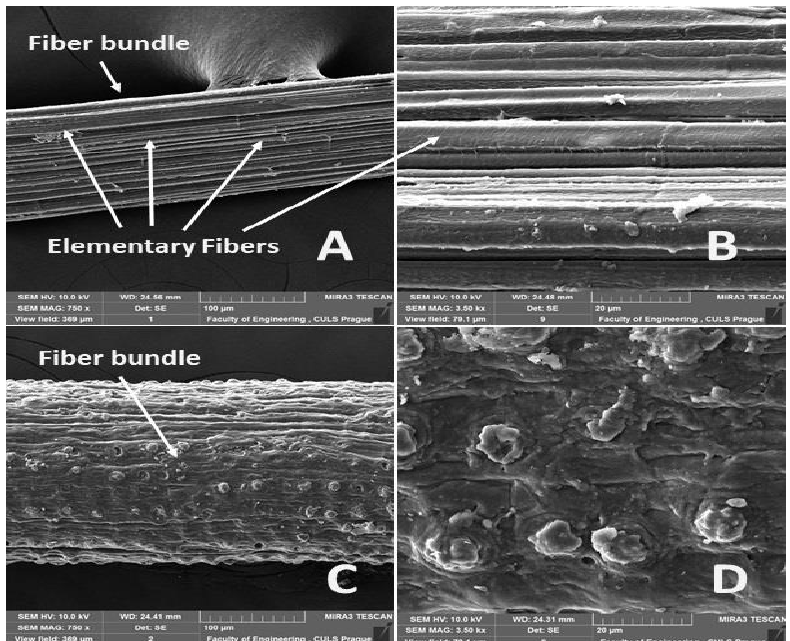
Figure 7. SEM images of the surfaces of abaca and coir fibers with treatment in a 5% solution of NaOH for 1 h ( A ): abaca fiber bundle (MAG 750 x), ( B ): detailed view of the surface of an abaca fiber (MAG 3.50 kx), ( C ): coir bundle (MAG 750 x), ( D ): detailed view of the surface of a coir fiber (MAG 3.50 kx).